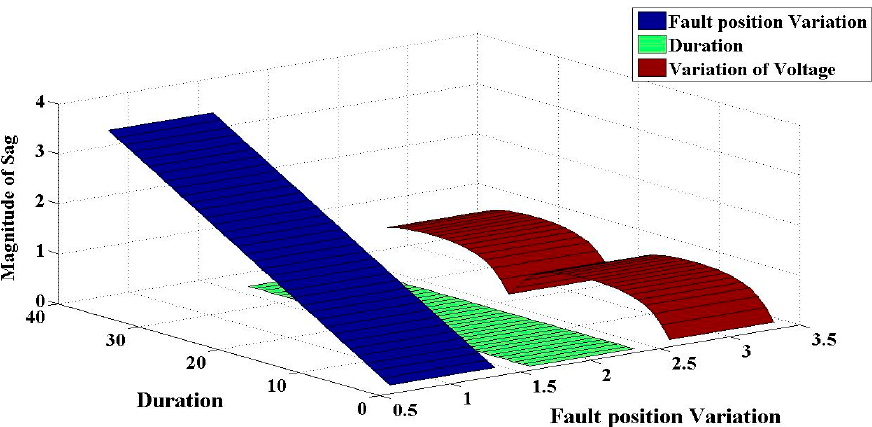
Figure 9. Three-dimensional ribbon plot of sag magnitude for different fault positions at a fixed duration of 80 ms.